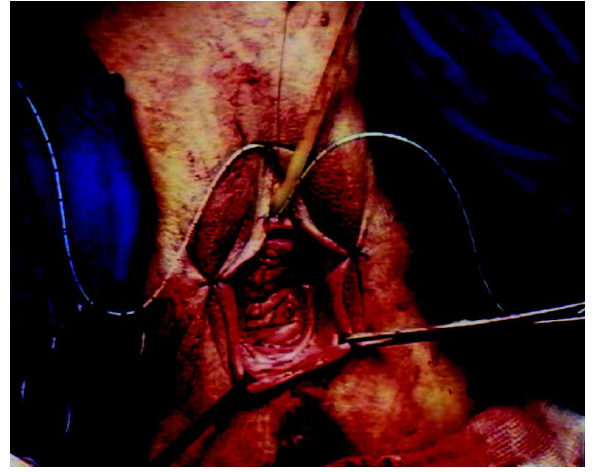
Figure 2 – Cystocele reduced until visualization of pubocervical fascia.